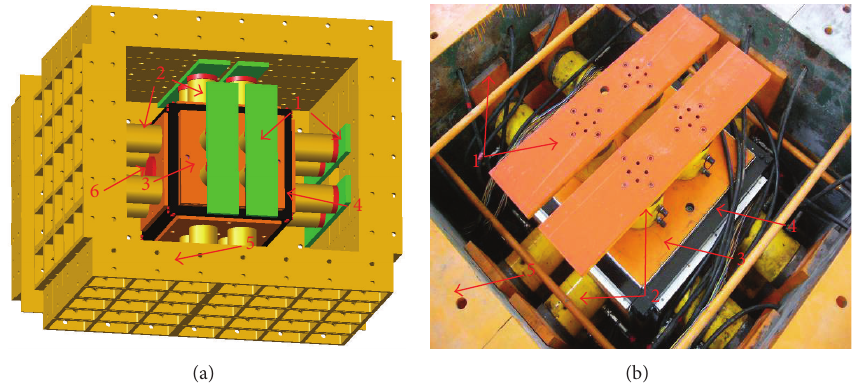
Figure 5: Sketch and photos of the true 3D model test system. The model was set inside the frame, and the platen was set into the frame at 0.5cm depth. Then, each direction of the model has the reserved displacement of 9cm. Notes: (1) junction plate, (2) hydraulic jacks, (3) loading platen, (4) oriented frame, and (5) combination reaction frame for loading (6) excavation guiding